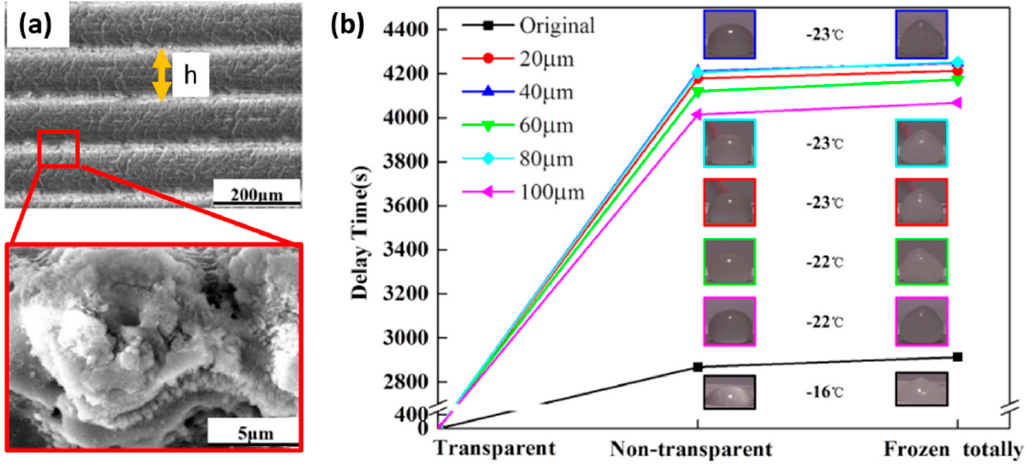
Figure 7. ( a ) SEM image of the laser processed surface by parallel scanning lines. Highlighted in red is an enlarged image of the cauliflower-like protrusions spread on the micro-gratings. ( b ) Delay times as a function of the pitch distance h (Adapted from [65], with permission from Elsevier).